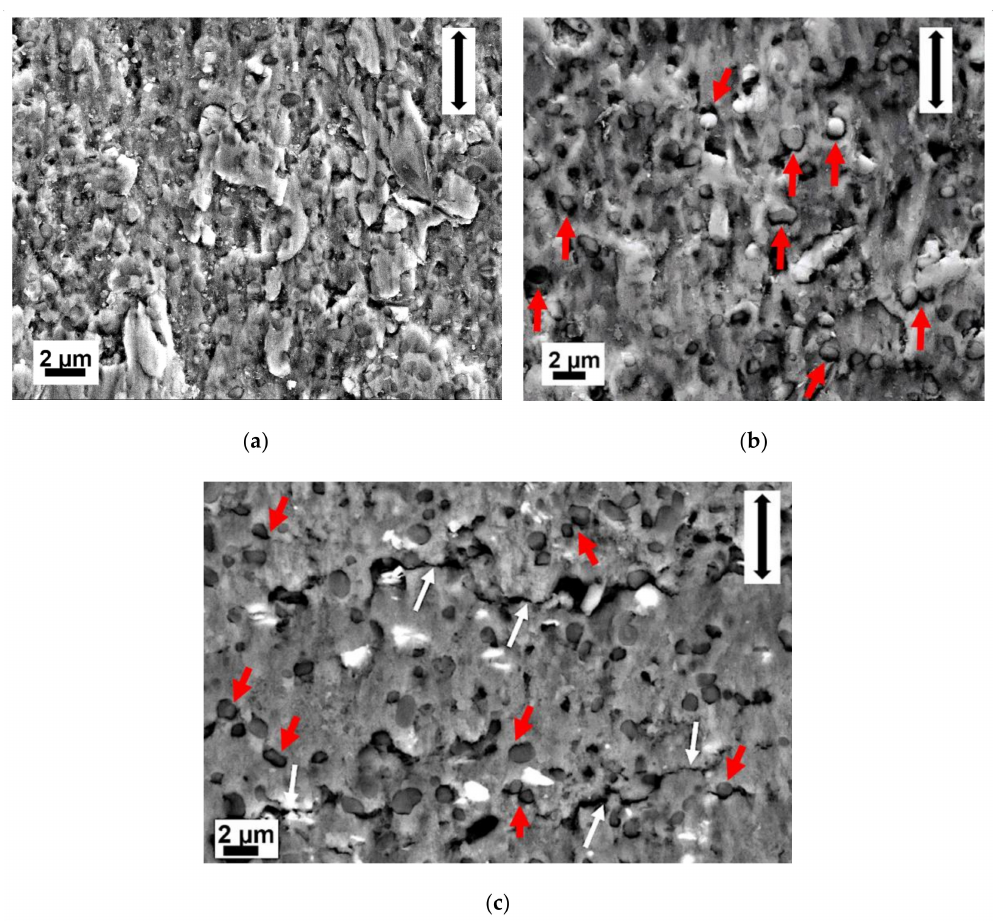
Figure 9. The worn surface of the discs tested against CP1180HD at 500 N (1.65 MPa) and 450 strokes: ( a ) VSC, ( b ) V8SC and ( c ) V40. White arrows indicate the fatigue cracks, and red arrows indicate the hard phase